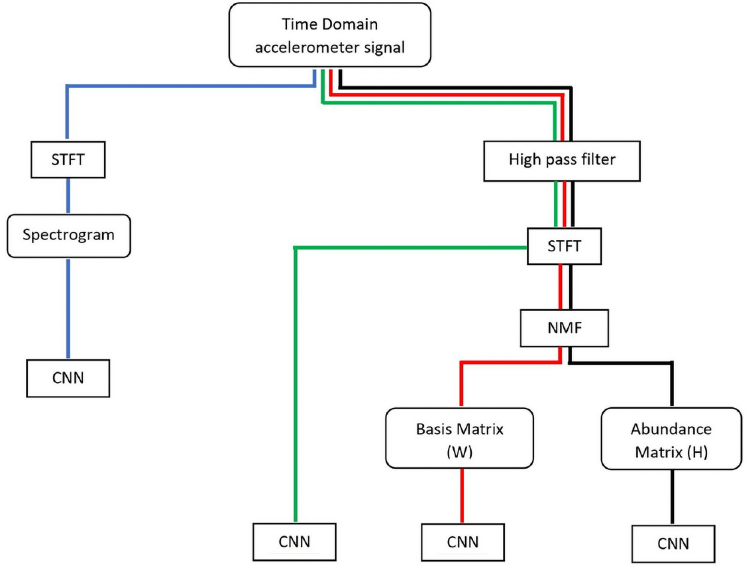
Fig 11. The flow of the four algorithms. The general flow of the four algorithms is presented in a graphical manner. The individual signal processing method utilized in each algorithm can be clearly observed.